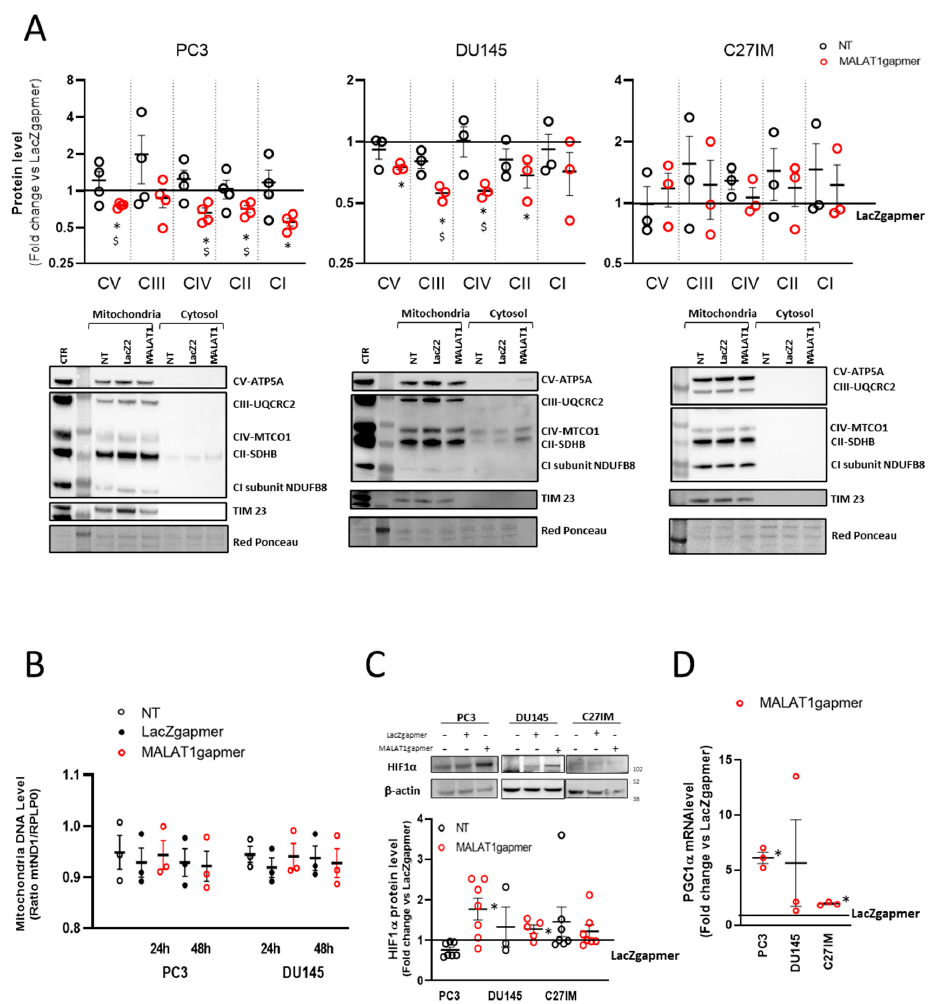
Figure 4. Metabolic alteration after MALAT1 depletion. ( A ) Western blotting analysis of OXPHOS complex subunit expression determined by using total OXPHOS antibody cocktail in PC3 (left), DU145 (middle), and C27IM (right) cells’ mitochondrial fractions upon MALAT1 depletion. Upper panels: Densitometric analysis plotted as fold change vs. LacZgapmer after normalization to loading control red ponceau. Lower panel: Representative western blotting experiments. Uncropped Western Blots of Figure 4A are available in Figure S9 ( B ) qRT quantification of mitochondrial DNA level in PC3 and DU145 cells at 24 h or 48 h after transfection with specific (MALAT1), control (LacZ), or no (NT) gapmer. Data are expressed as ratio mtND1 vs. RPLP0 level. ( C ) Representative western blot and densitometry analysis for HIF1 α assessed in 3 different PCa cells (PC3, DU145, and C27IM) not transfected or transfected with MALAT1 or LacZgapmers. β -actin was used as a loading control. Uncropped Western Blots of Figure 4C are available in Figure S10 ( D ) qRT expression of PGC1alpha mRNA in different PCa cells (PC3, DU145, and C27IM) interfered with MALAT1 or LacZgapmers. Results are plotted as fold induction vs. LacZgapmer taken as reference value 1 (straight black line). Individual values ( n = 3–8) with mean ± SEM are shown. Non-parametric paired two-tailed Student’s t -test determined statistical significance. * p ≤ 0.05 MALAT1gapmer vs. LacZgapmer. $ p ≤ 0.05 MALAT1gapmer vs.